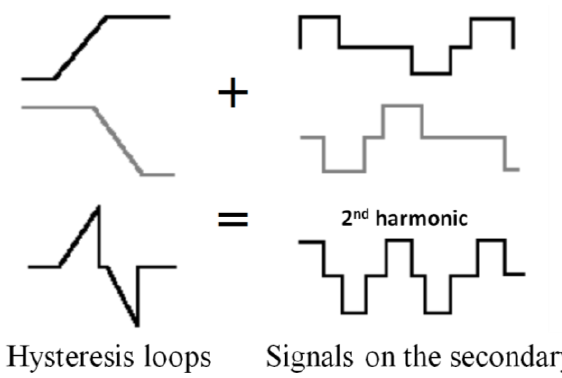
Figure 9. Signal of each core applying an external field.